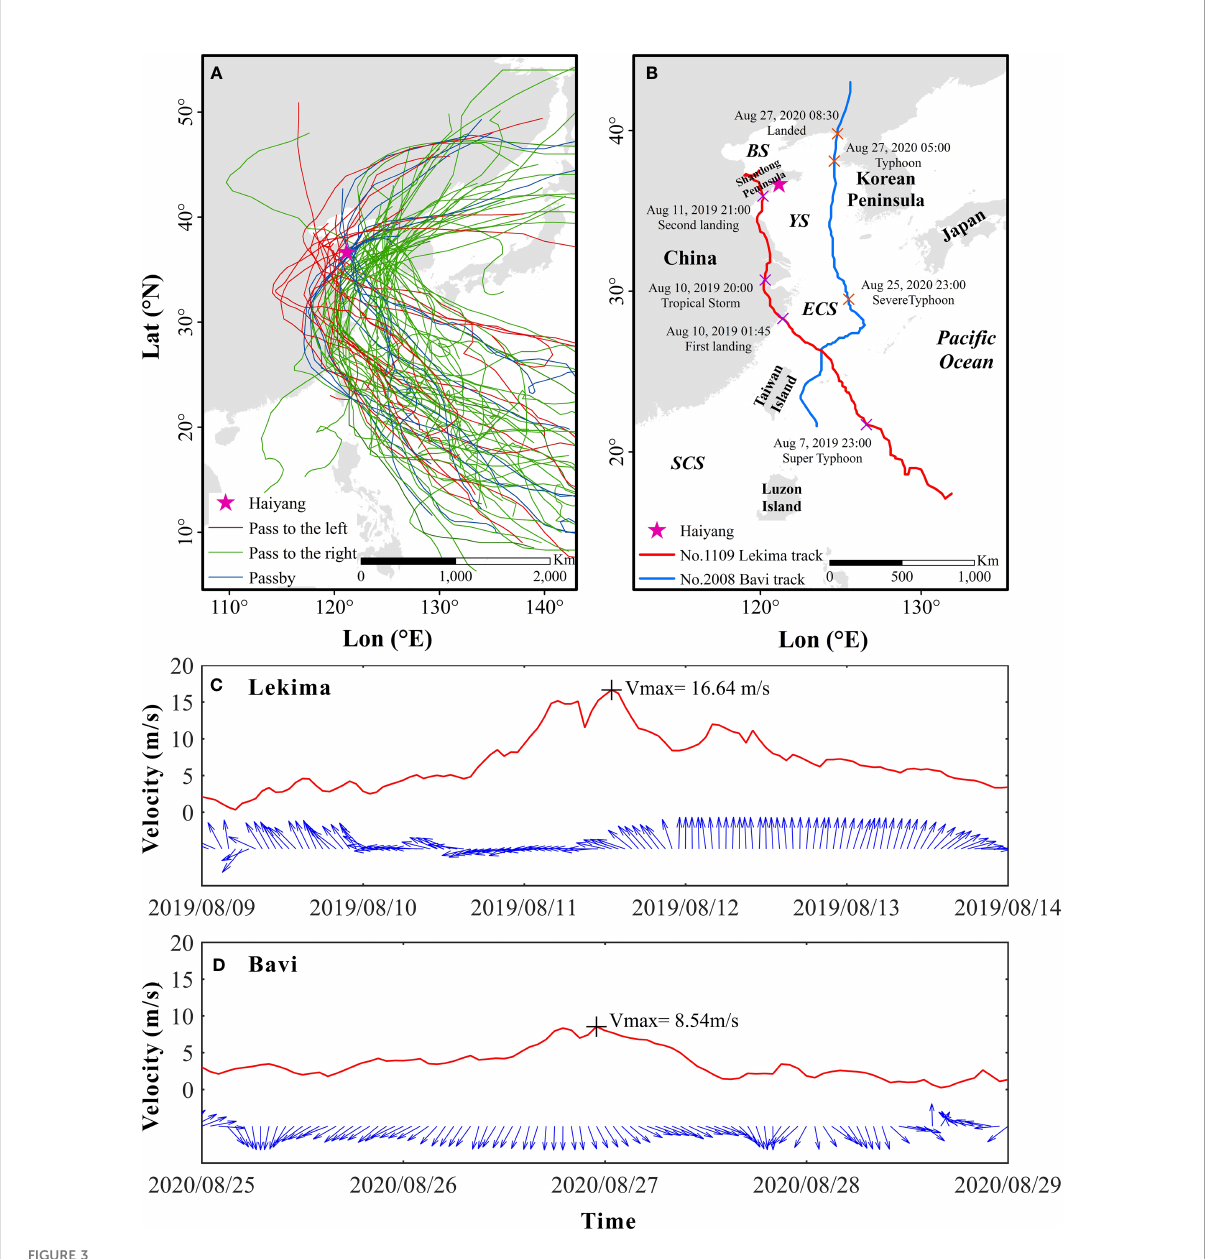
FIGURE 3 Tracks of the historic TCs that affected the Shandong Peninsula from 1949 to 2020 (A) . Tracks of the Lekima and Bavi considered in this study (B) . Hourly time series of wind velocity (red line) and direction (blue arrows) at Haiyang beach (the wind site in Figure 1C) during Lekima (C) and Bavi (D) ,